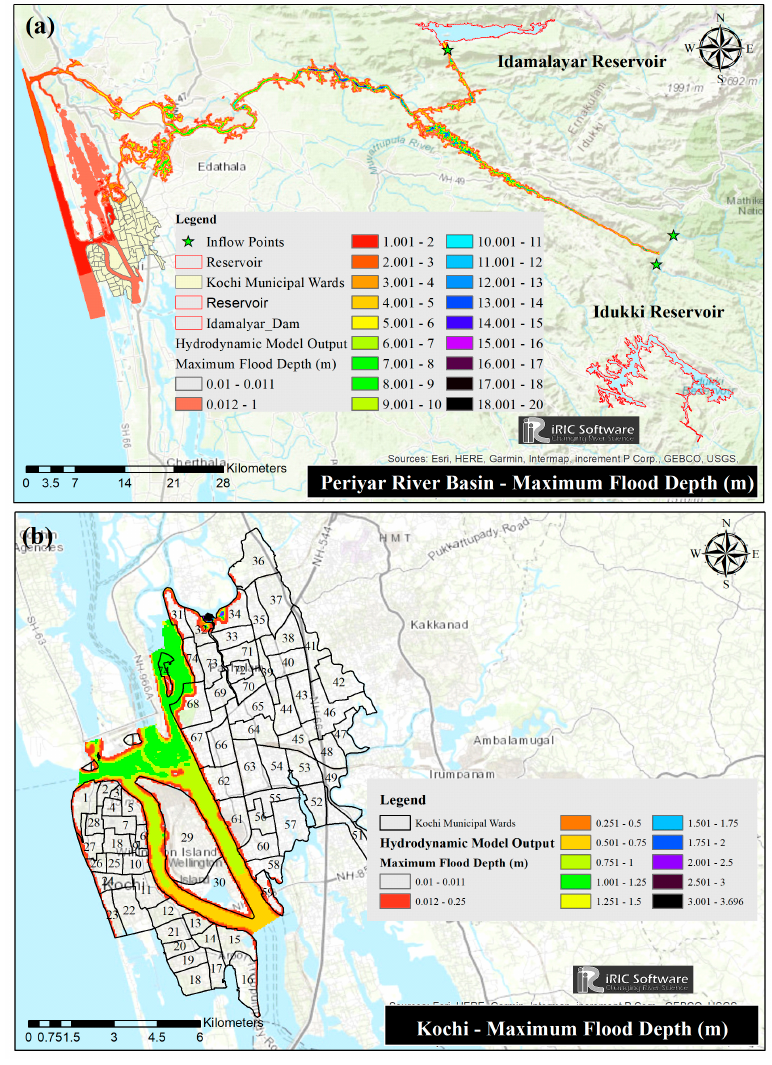
Figure 11. Hydrodynamic model flood depth output of Kochi city and Periyar river basin under natural flow condition (without reservoir operation) where ( a ) shows the maximum flood depth in Periyar River Basin and ( b ) shows maximum flood depth in the Kochi City